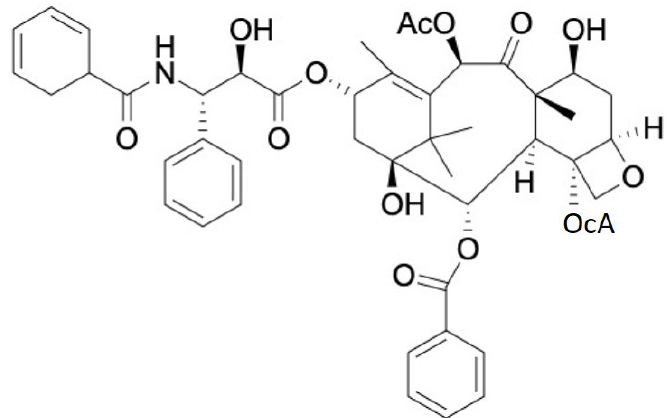
Figure 2. The structure of PTX.